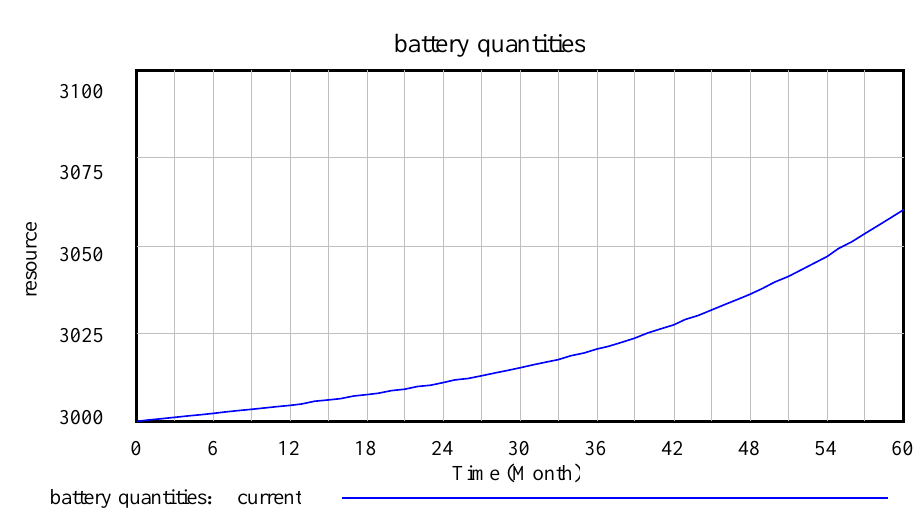
Figure 5. Battery quantity.